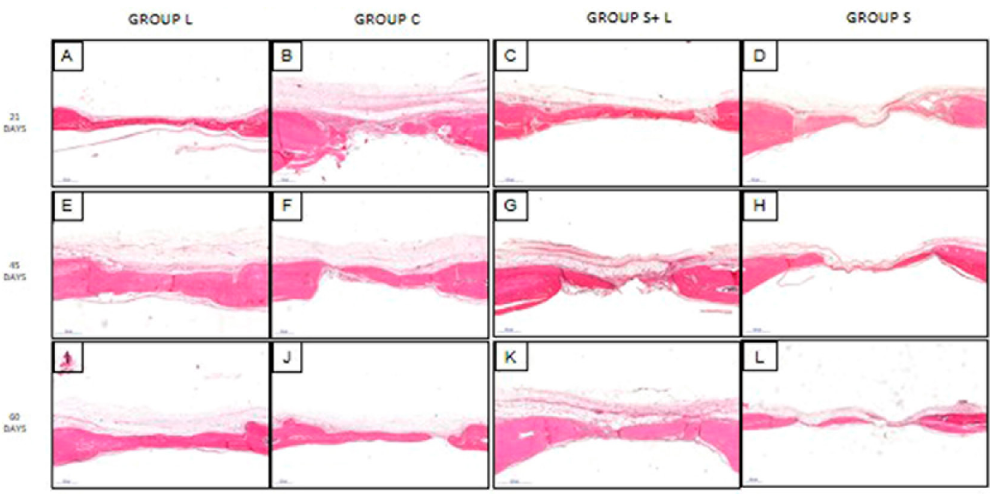
Figure 1- Photomicrography of histomorphometric analysis of groups on each experimental period. Group L (A, E and I); Group C (B, F and J); Group S+L (C, G and K); Group S (D, H and L) at 21, 45 and 60 days. Scale 500 μm and 2X magnification